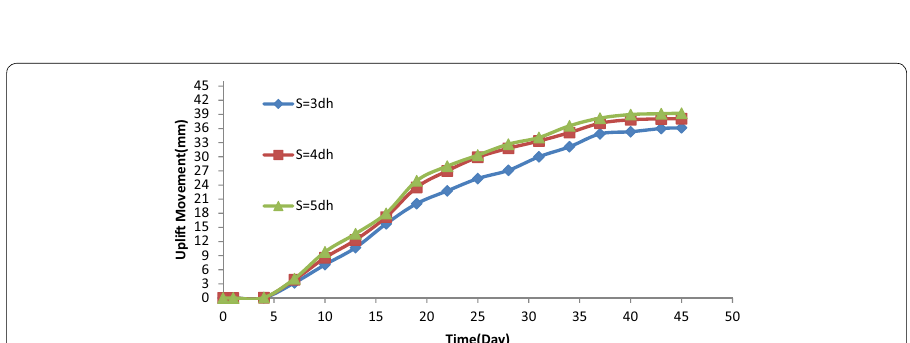
27 and double helix (dh =